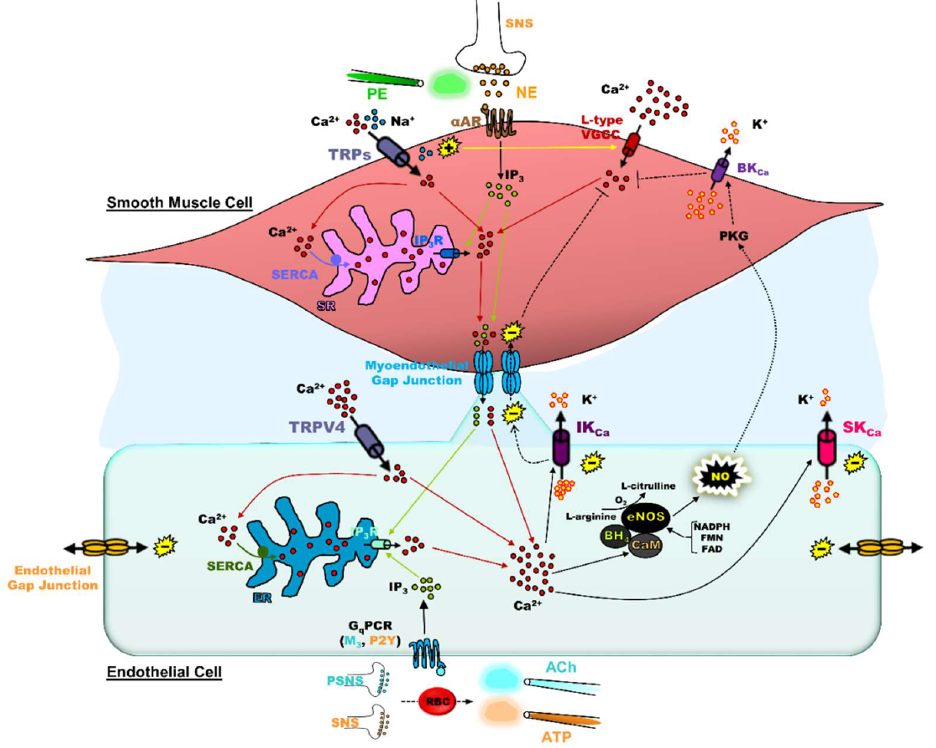
Figure 1. Anatomy of endothelium-derived hyperpolarization and myoendothelial coupling. Endothelium: Physiological stimulation of endothelial G q -protein-coupled receptors (G q PCRs; muscarinic (M 3 ), purinergic (P2Y)) occurs through neurotransmitter